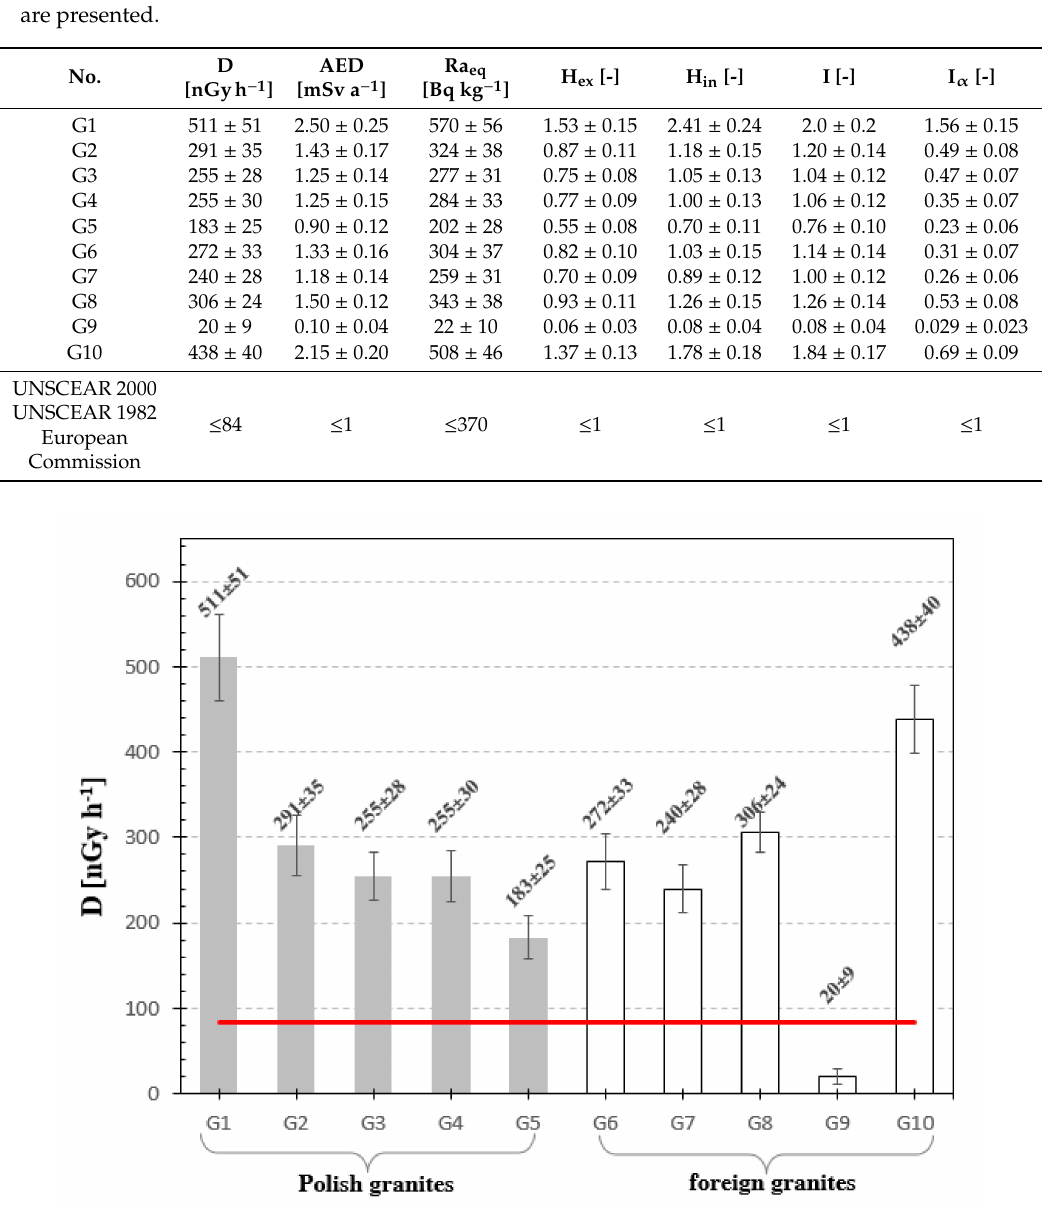
Figure 6. Absorbed gamma dose rate for analyzed samples. The horizontal line indicates the recommended value 84 nGy / h [22] for natural